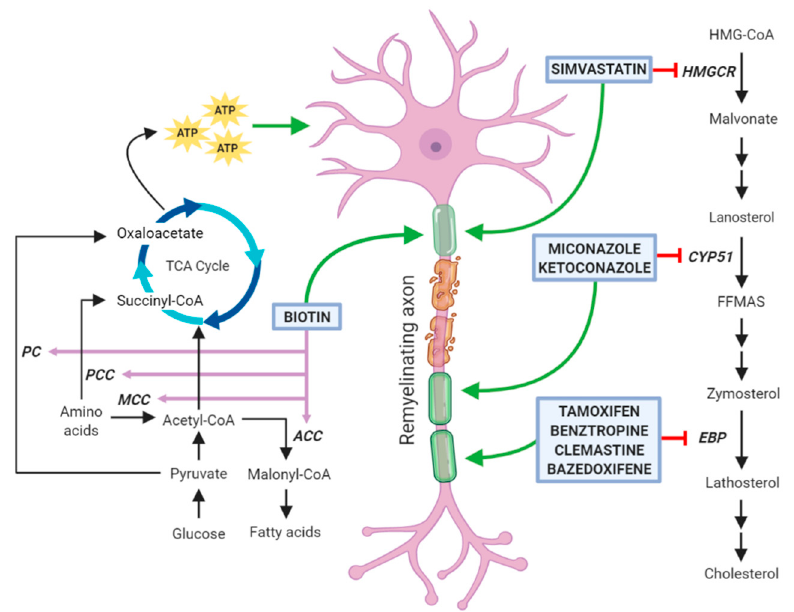
Figure 2. A consistent number of the most promising remyelinating molecules acts on enzymes involved in the biosynthesis of fatty acids or cholesterol. Remyelinating drugs currently under investigation for multiple sclerosis in pre-clinical or clinical trials are reported. Among them biotin can act in oligodendrocytes as co-factor for the enzyme acetyl-CoA carboxylase (ACC) which is the rate-limiting and committing step for the synthesis of malonyl-CoA, the building block for fatty acid synthesis. Biotin can also induce an increased ATP pool in neurons, by acting as co-enzyme for propionyl-CoA carboxylase (PCC), 3-methylcrotonyl-CoA carboxylase (MCC) and pyruvate carboxylase (PC). On the other hand, simvastatin, miconazole, tamoxifen, benztropine, clemastine and bazedoxifene inhibit enzymes located at di ff erent levels of the cholesterol biosynthesis. Abbreviations: HMG-CoA,3-hydroxy-3-methyl-glutaryl-coenzymeA;HMGCR,HMG-CoAreductase; CY51, lanosterol 14 α -demethylase; FFMAS, follicular fluid meiosis-activating sterol; EBP, Emopamil-Binding